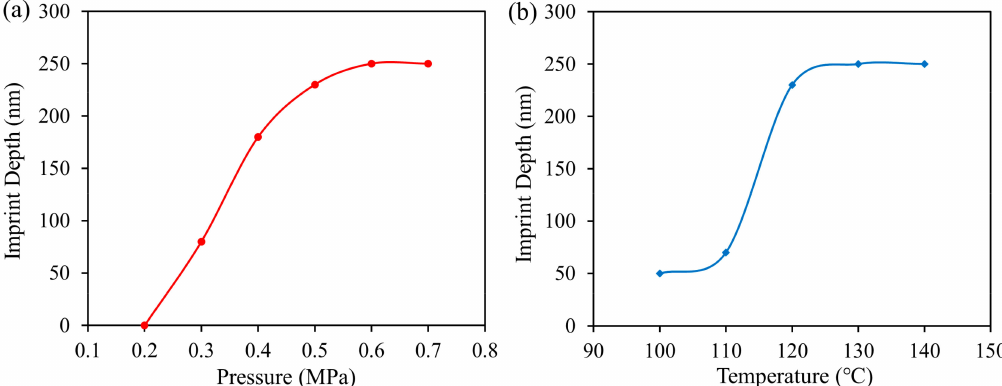
Figure 4. ( a ) Plot of the depth of imprinted poly(methyl methacrylate) (PMMA) nanoholes vs imprint pressure under the imprint temperature of 120 ◦ C; and ( b ) plot of the depth of imprinted PMMA nanoholes vs imprint temperature under the imprint pressure of 0.5 MPa. The height of nanopillars on the mold is 250